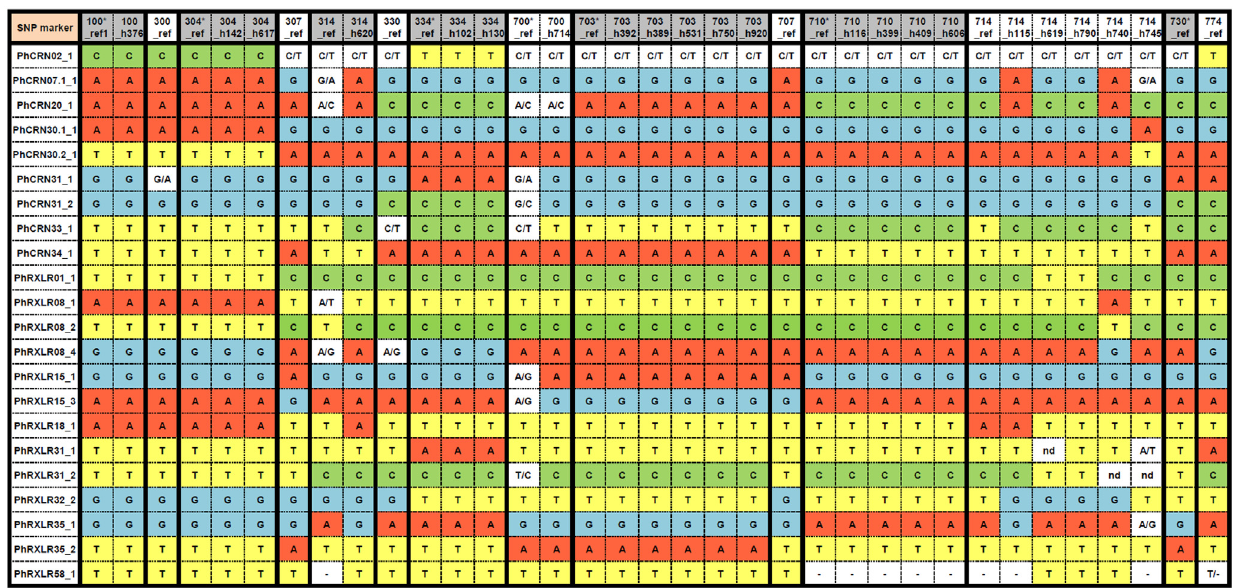
Fig 3. Genotypes of 14 reference isolates (_ref) and 21 geographical isolates of Pl . halstedii for 22 KASP markers based on effector gene SNPs. The DNA base involved in polymorphism is indicated by a specific colour. Heterozygous DNA bases are separated with a slash. ( – ) sign corresponds to the absence of the indel (versus T in PhRXLR58_1). * Genomic sequences of effectors available for these pathotypes (S1_File). Not determined results: nd.